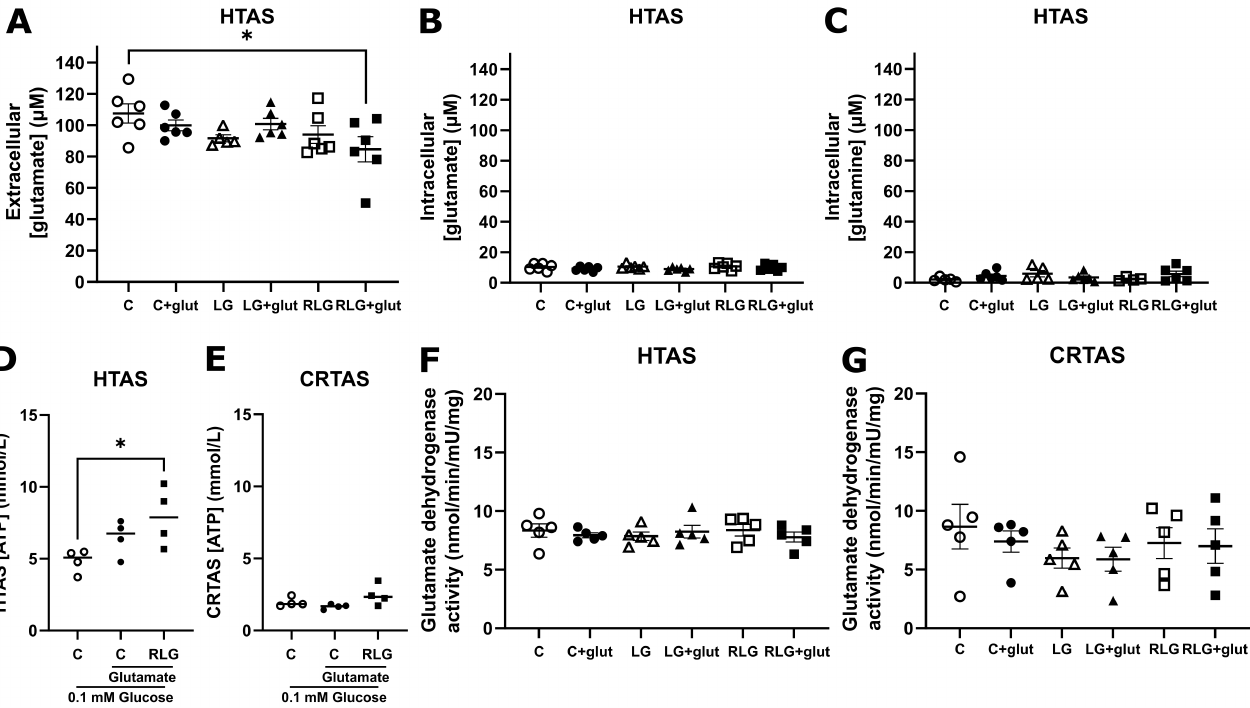
Figure 7. Co-treatment with glutamate in recurrent low glucose increases uptake of glutamate and sustains ATP levels after extended low glucose in hypothalamic astrocytes. After control, acute low glucose (LG) recurrent low glucose (RLG) with and without glutamate HTAS cell lysates and conditioned media were analysed. Extracellular glutamate concentrations (( A ); n = 5–6). Intracellular glutamate concentrations (( B ); n = 6). Intracellular glutamine concentrations (( C ); n = 5–6). ATP levels of HTAS ( D ) and CRTAS ( E ) cellular contents and conditioned media together after exposure to low glucose for 3 h. Activity of intracellular glutamate dehydrogenase activity of HTAS ( F ) and CRTAS ( G ). Error bars represent standard error of the mean. One-way ANOVA with post hoc Tukey’s multiple comparisons test. * p <